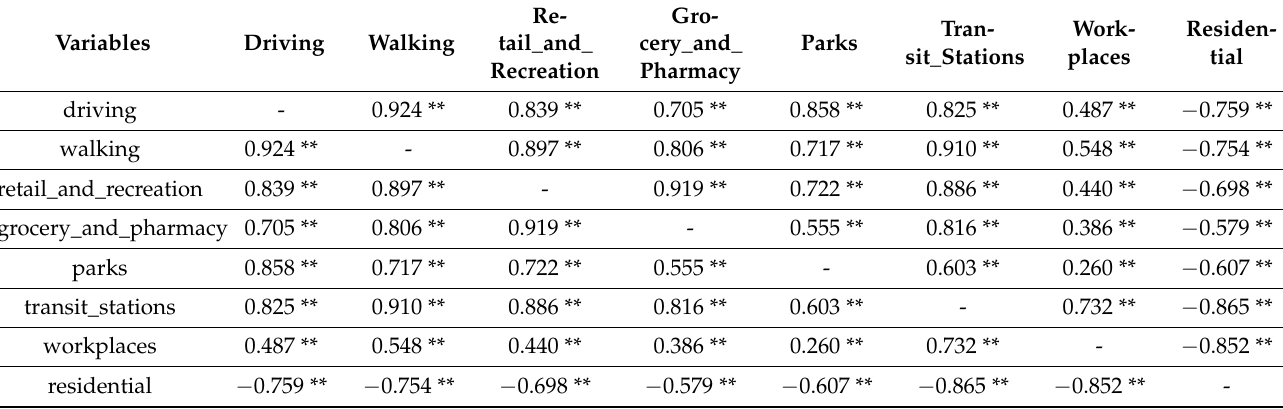
Table A2. Correlations between variables belonging to group Mobility in Portugal.